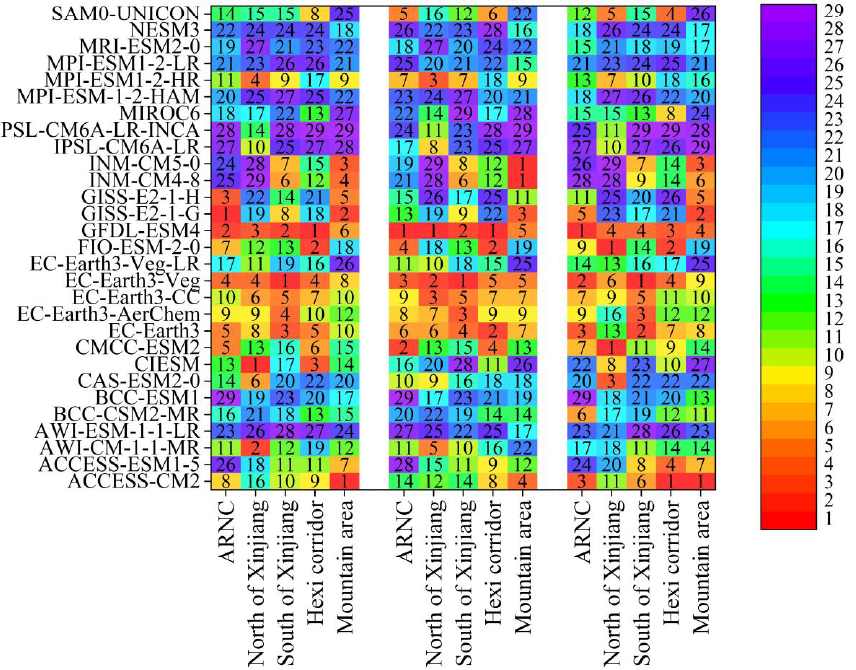
Figure 5. Color scale diagram of comprehensive ranking of models in simulating temperature mean field (the left column, tas; the middle column, tasmax; the right column, tasmin).